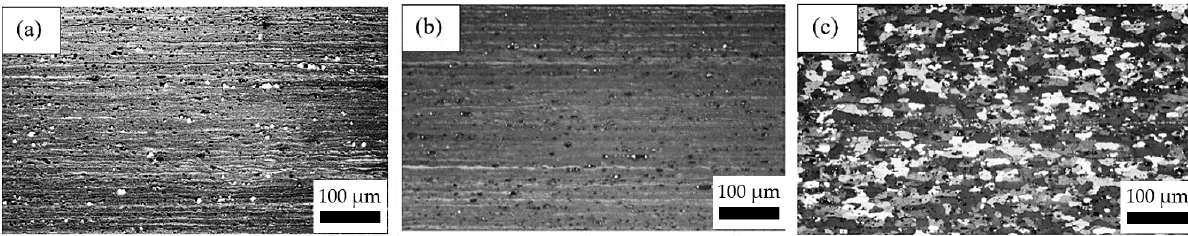
Figure 6. Optical micrographs after Barkers electrolytic etching showing the microstructure of ( a ) c.r.AR, ( b ) rc.AR and ( c ) rx.AR.